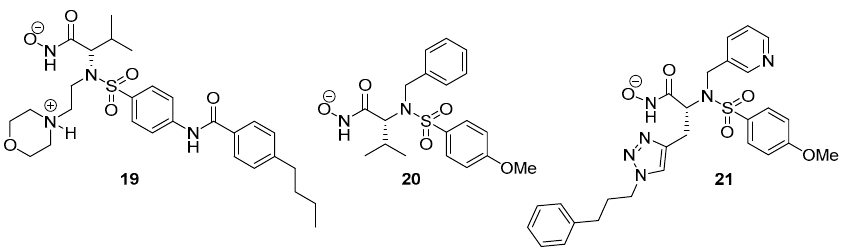
Figure 2. MMP inhibitor 19 (SC-74020) constructed for use as a model for docking and ionized form of BNCT agents 20 and 21 used in docking experiments.